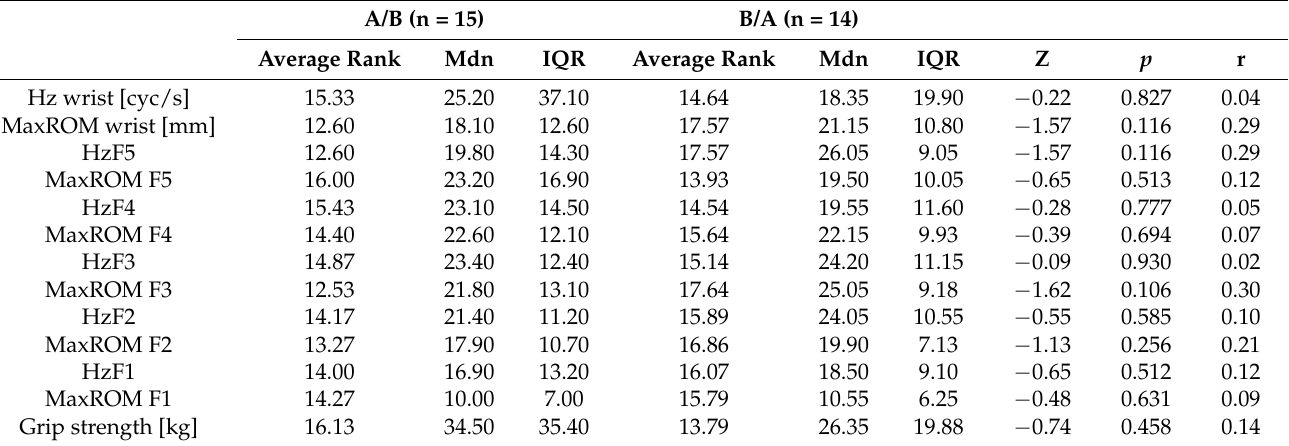
Table 4. Comparison of groups in terms of the sum of parameters from the first and second measure- ment with